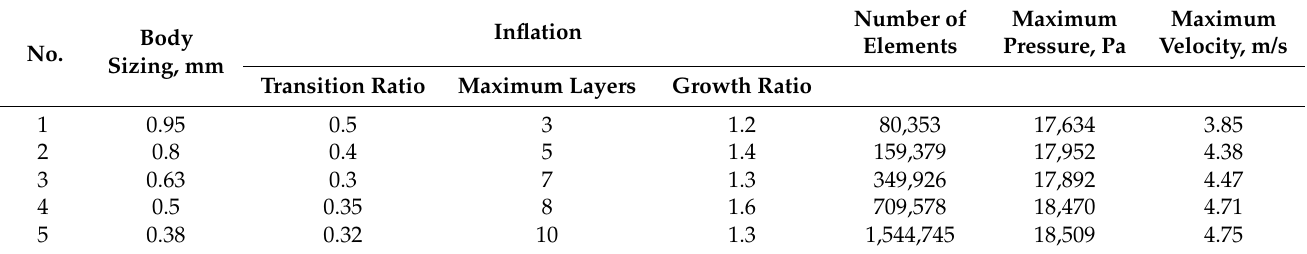
Table 1. Parameters of samples used in the study.